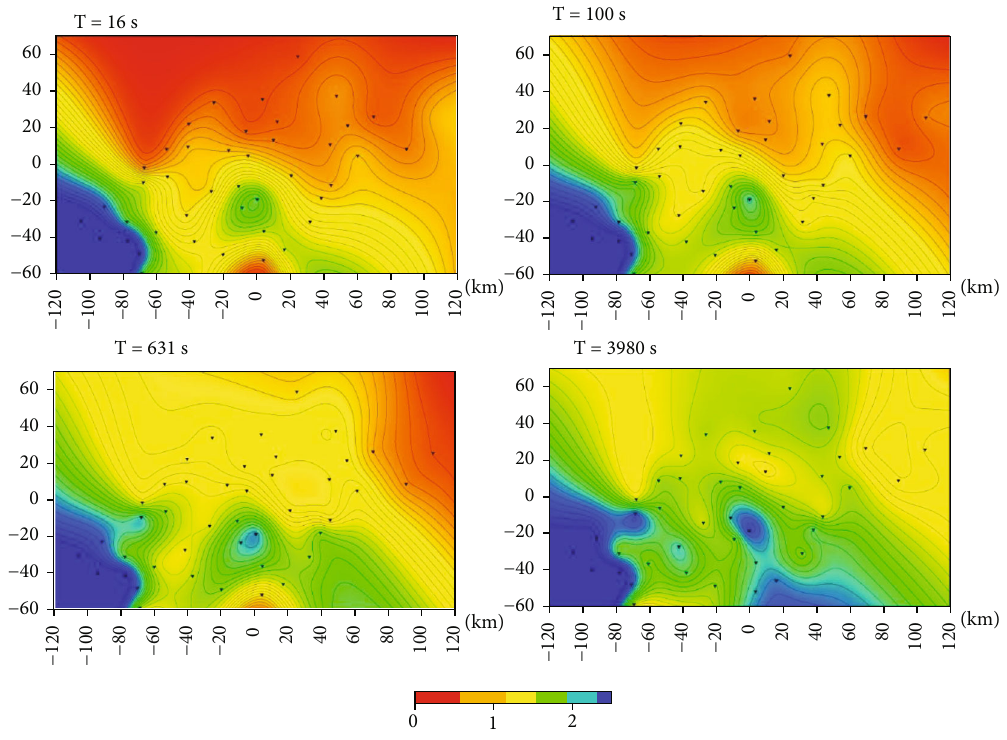
Figure 5: Presentation of e ff ective impedance for selected periods (16, 100, 631, and 3980